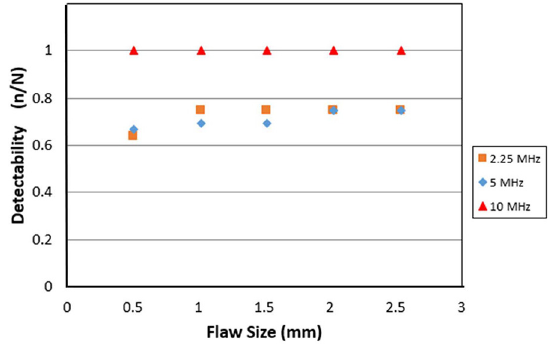
Figure 5. Detectability of fl aws